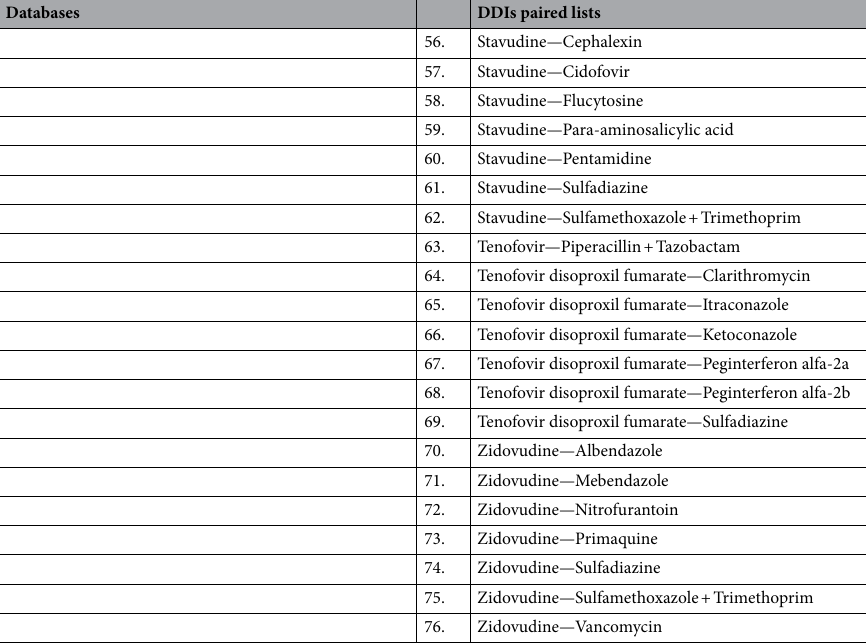
Table 3. Drugs pairs with poor concordance in DDI severity grading across databases.